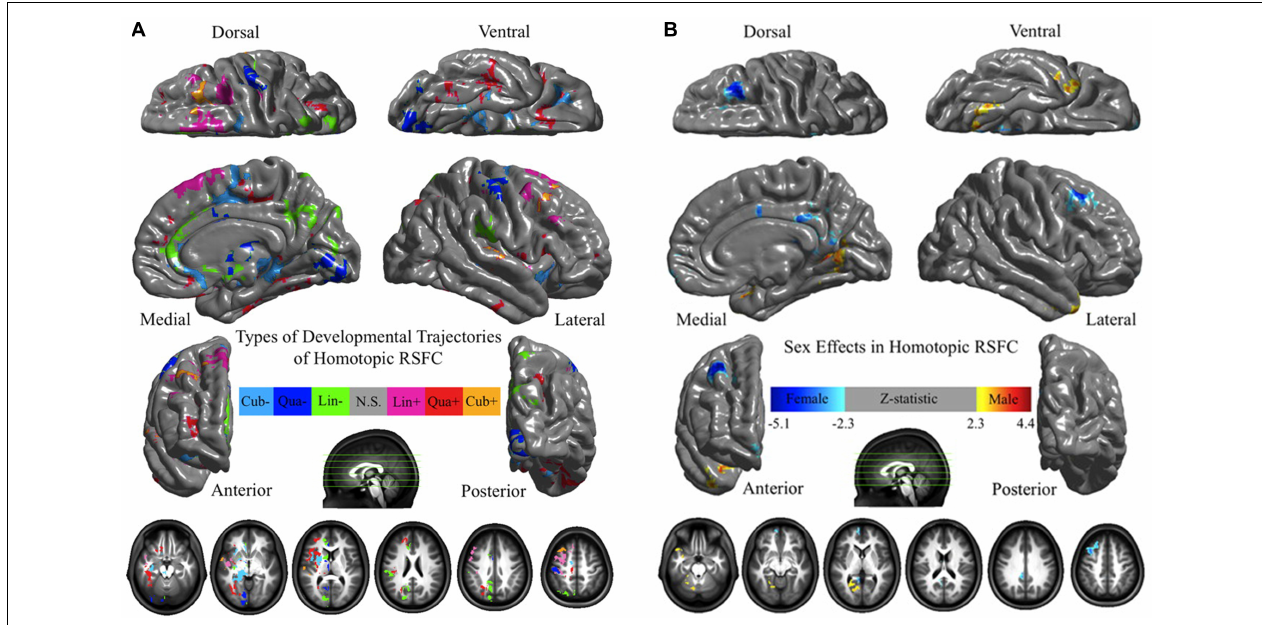
FIGURE 3 | The physiological effects on HoFC. (A) Age effects on HoFC. The linear (Lin), quadratic (Qua), and cubic (Cub) effects of age on VMHC were shown at each voxel, evaluating through multiple linear regressions model. (B) Sex effects of HoFC. One-sample tests on regression coefficients of sex was performed for both positive and negative contrasts. These figures are adapted from Zuo et al. (2010). Permission to reuse Figures 3 , 5 from the article was granted by the Creative Commons Attribution-Non-commercial-Share Alike 3.0 Unported License